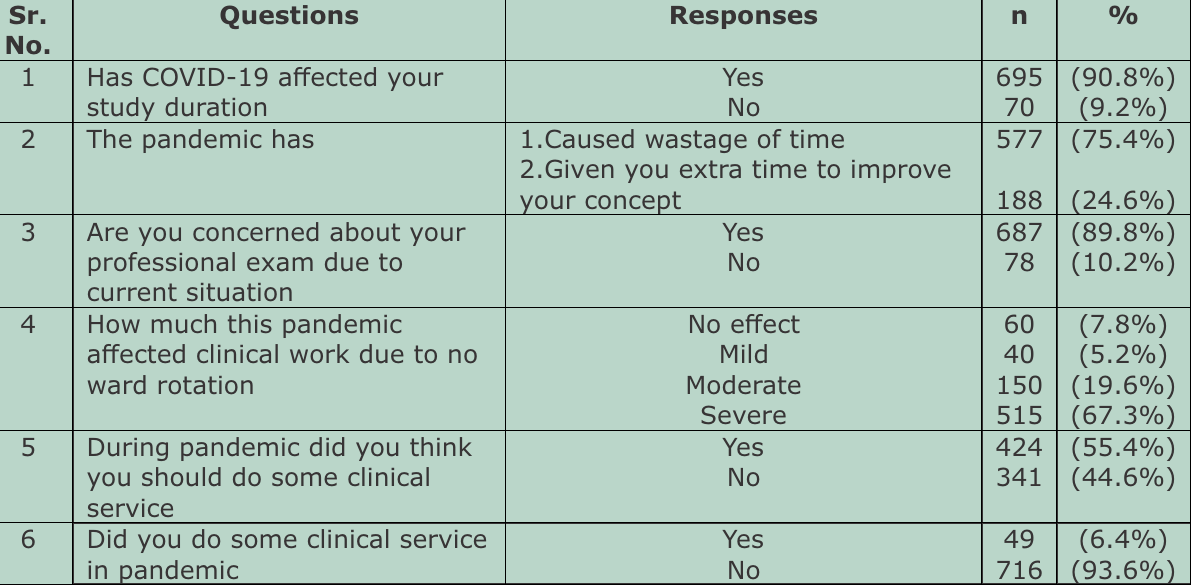
Table-II: Frequency Distribution of responses by the participants of the survey (n=765).